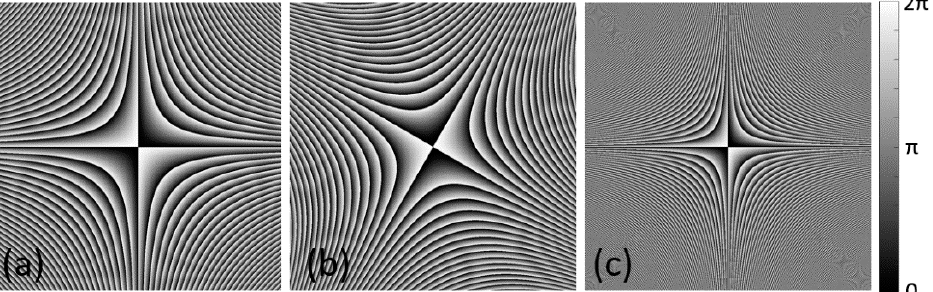
Figure 4. Phase graphs of the twisting phase. ( a ) u = 10 mm − 2 , θ = 0; ( b ) u = 10 mm − 2 , θ = π /3; ( c ) u = 30 mm − 2 , θ =